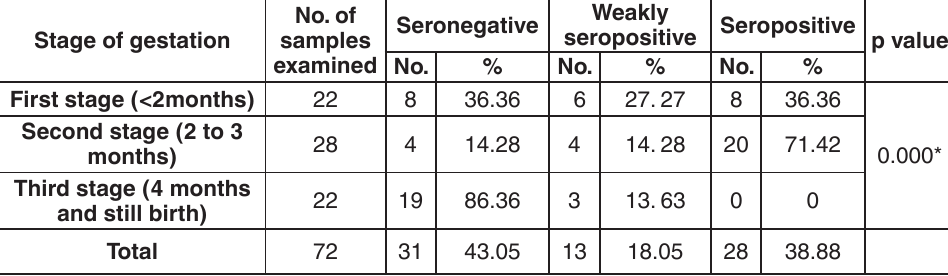
third stage (4 months and still birth)